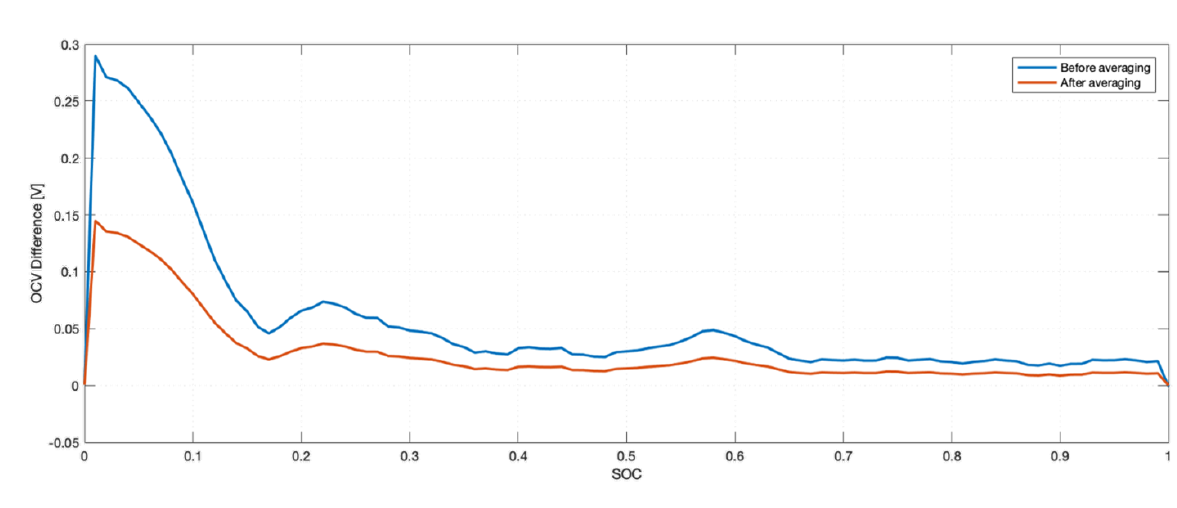
Figure 3. OCV versus SOC at 25 °C.